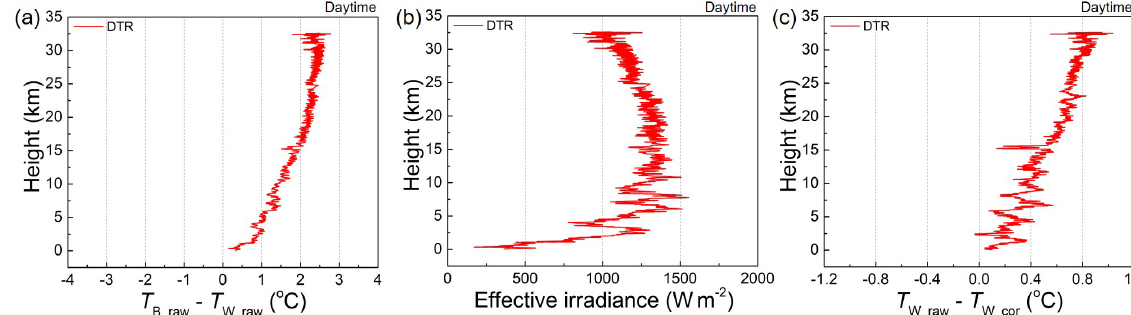
Figure 8. Sounding test of dual thermistor radiosondes. (a) Raw temperature difference between the white and black sensors ( T B_raw − T W_raw ), (b) effective irradiance based on ( T B_raw − T W_raw ) calculated by Eq. (10) and (c) radiation correction value of the white sensor in the daytime calculated by Eq.